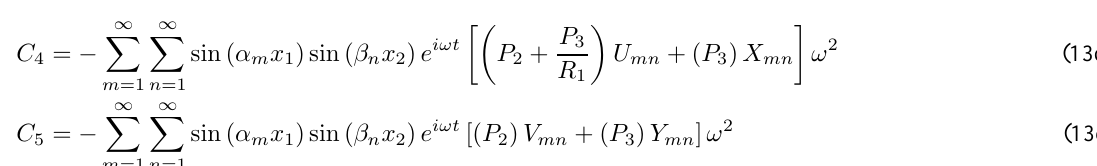
Fig. 3. Normalized natural frequencies for isotropic cylindrical panel with b/a =